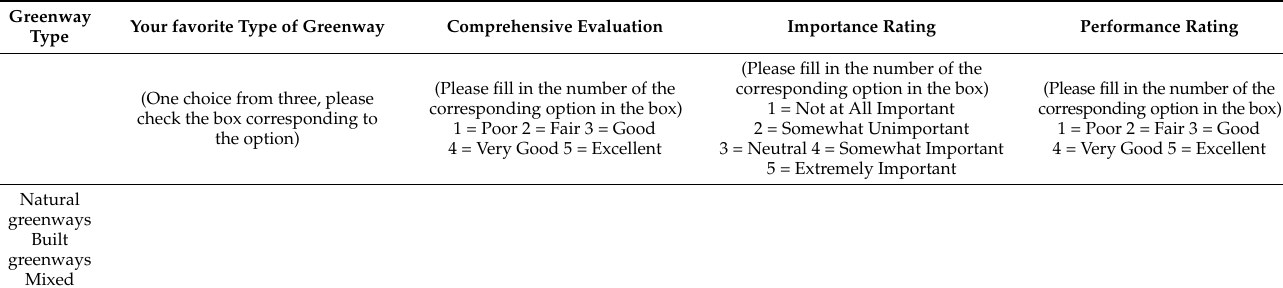
Table A3. What is your preference for Huangpu riverside greenway? And how do you evaluate the importance and performance of Huangpu riverside